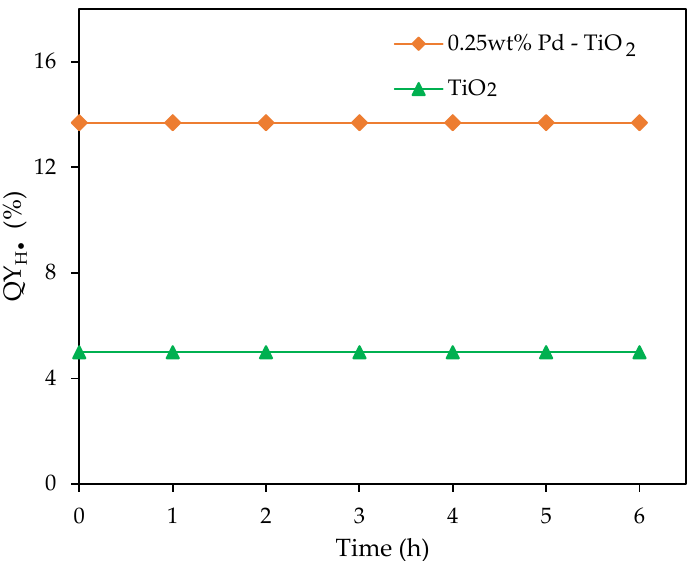
Figure 12. QY H • % for a 0.25 wt% Pd-TiO 2 and for undoped TiO 2 at various irradiation times, under near-UV Light. Conditions: 0.15 g L −1 of photocatalyst; initial pH = 4 ± 0.05; 2.0% v / v ethanol.